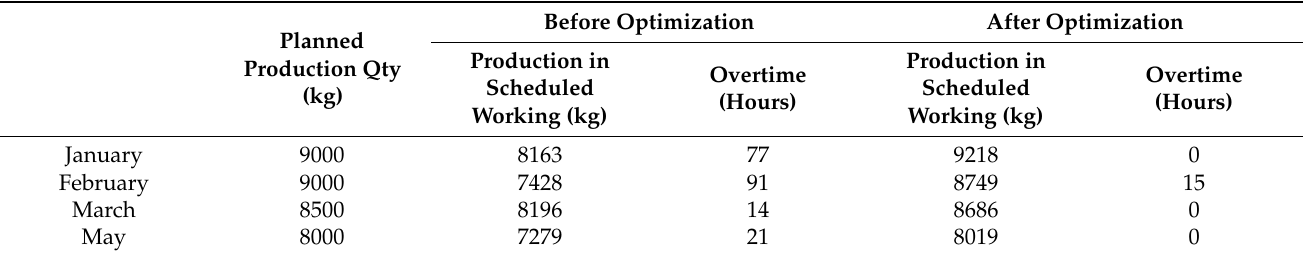
Table 7. Data after optimization.